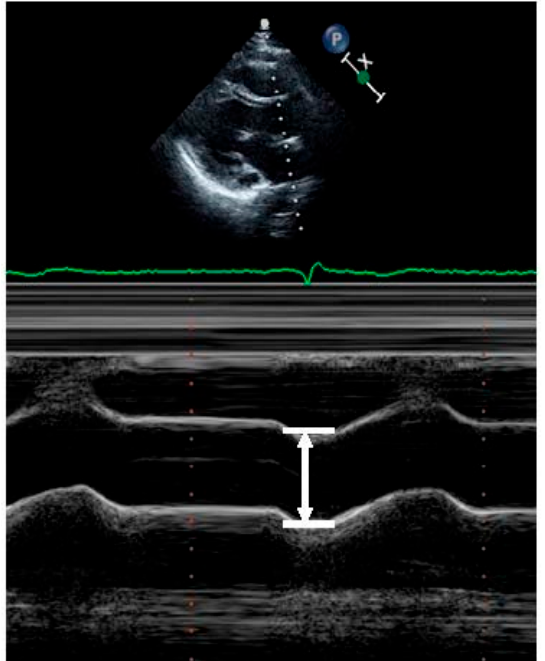
Figure 3. Measurement of aortic root diameter on M-mode echocardiograph. For measurement of aortic root diameter, place the cursor over the aortic valve cusps. Identify diastole when start of the